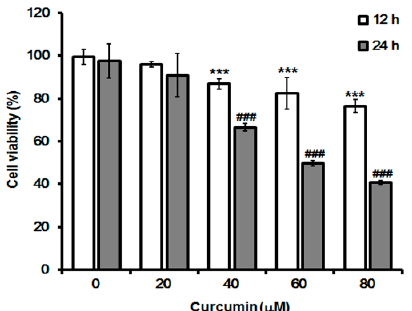
Figure 1. Effect of curcumin on A549 cell viability. The cytotoxic effects of curcumin on A549 cells were examined by MTT assay. Cells were cultured in growth medium at different concentrations (0–80 μ M) for 12 h and 24 h, and absorbance at 540 nm was measured using an ELISA reader. Bar graphs indicate the percentage of viability. All data are expressed as mean ± SEM of three independent experiments. *** p < 0.0001 compared with white bar 0 μ M. ### p < 0.0001 compared with gray bar 0 μ M.